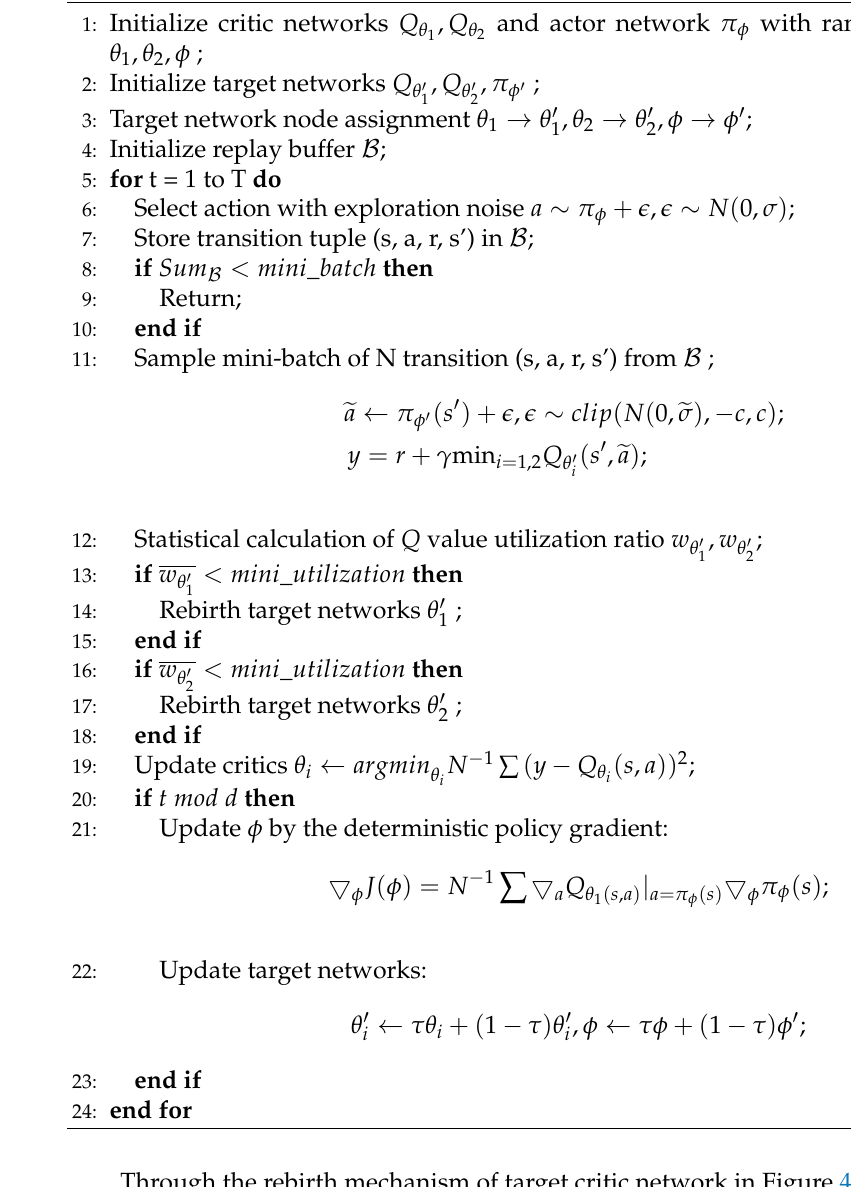
Algorithm 1 Algorithm